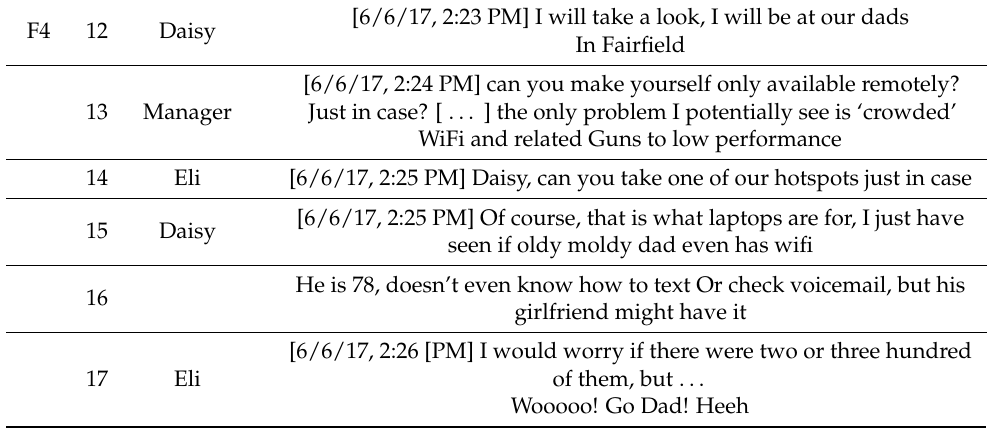
Table 5. F5 (“Dad is a Lady’s Man” frame).